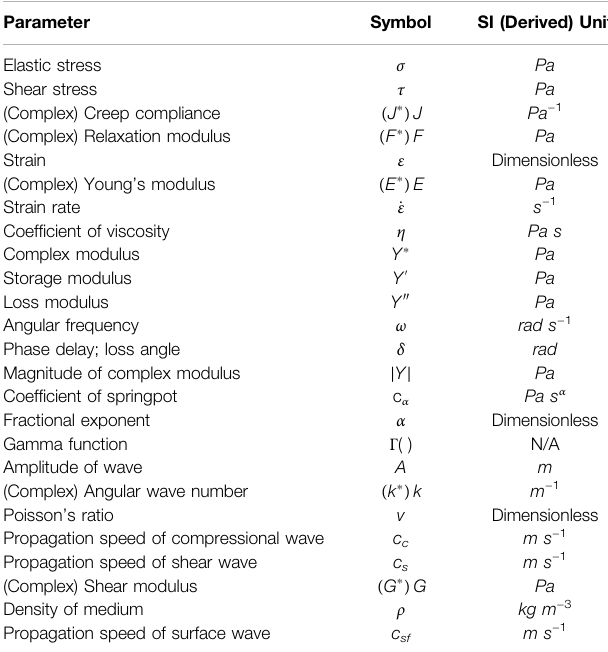
TABLE 1 | Glossary of